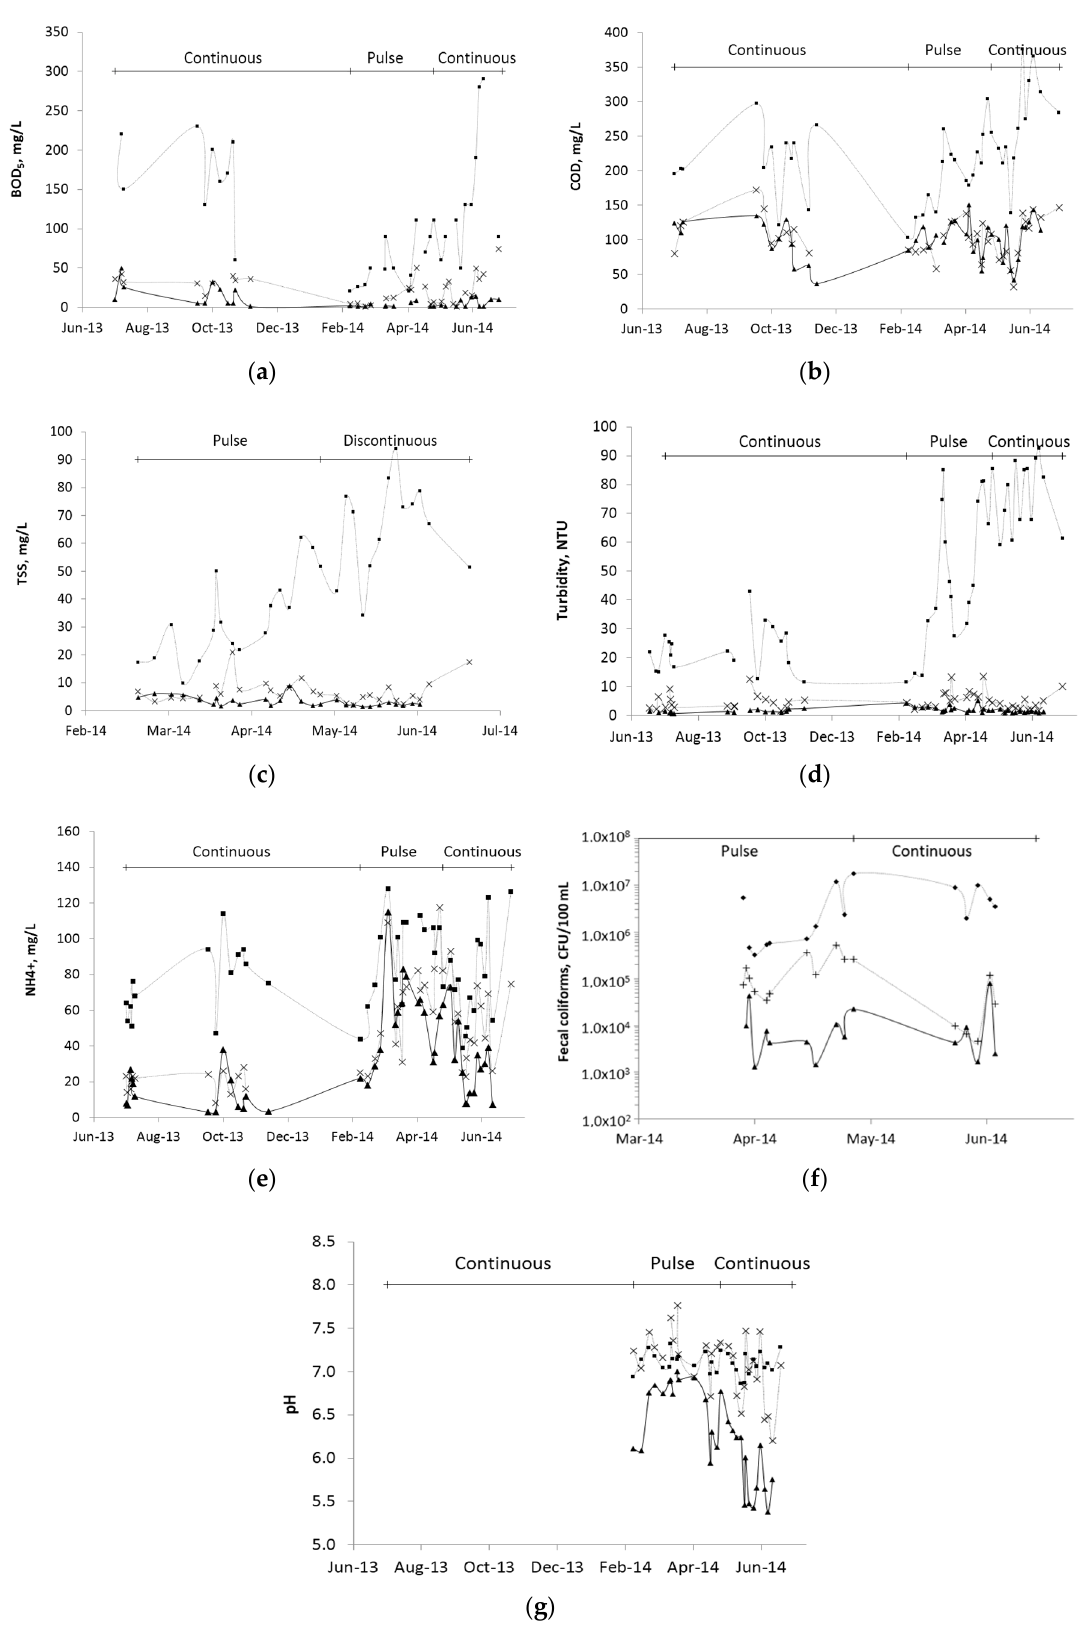
Figure 3. Values in the influent of the secondary constructed wetlands (- ■ -, dashed line) and effluents of VFmulch2 (- ▲ -, solid line) and VFgravel2 (-x-, dashed line) of: ( a ) BOD; ( b ) COD; ( c ) TSS; ( d ) turbidity; ( e ) NH 4+ ; ( f ) fecal coliforms; ( g ) pH.